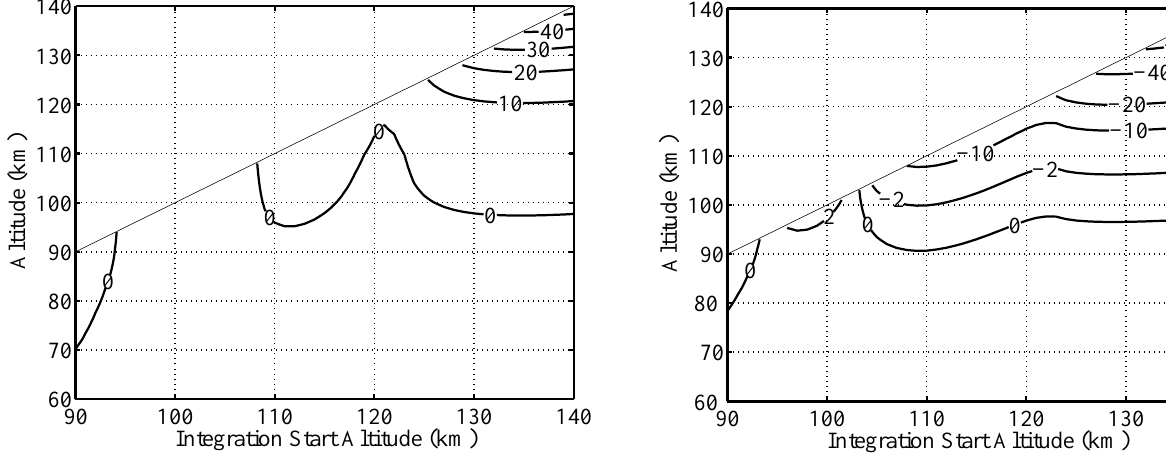
Fig. 9. Mid latitude – measurements made during disturbed solar activity and processed assuming moderate solar activity, including the selection of the seeding